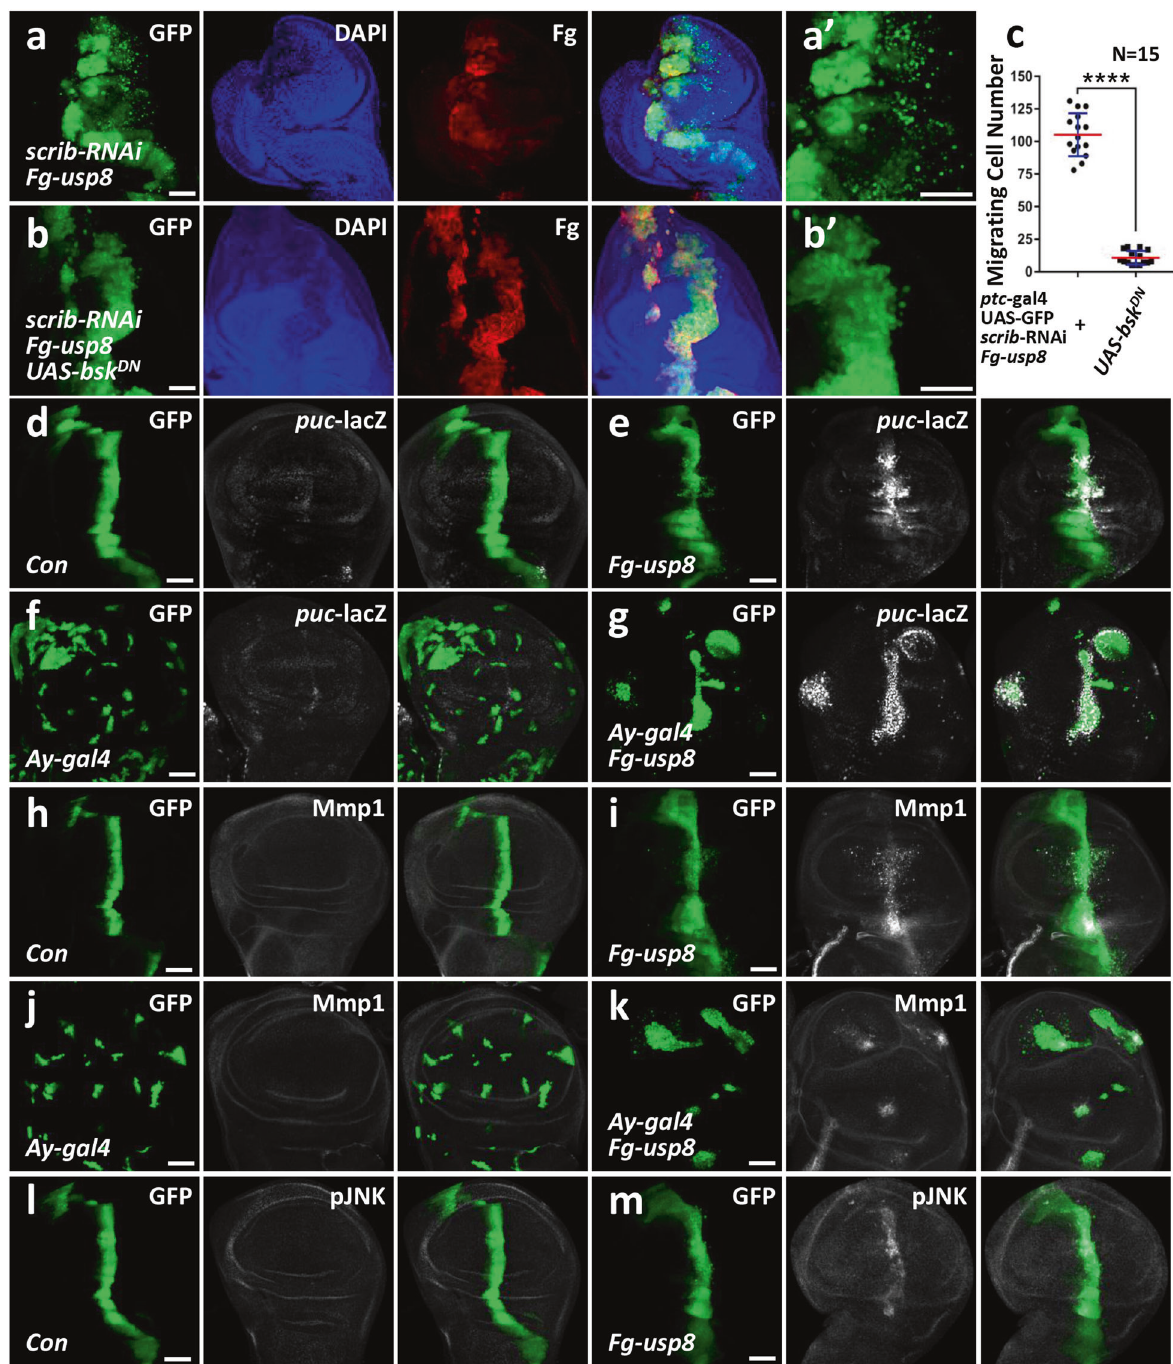
Fig. 2 Usp8 triggers cell migration through activating the JNK pathway. a Ectopic expression of usp8 under scrib RNAi background induced robust cell migration in the wing disc. a ’ was an enlarged fi gure of a . b Overexpression of bsk DN blocked usp8 -induced cell migration under scrib RNAi background. c Quanti fi cation analyses of migrating cell numbers in a, b ( N = 15). d A control third-instar larvae wing disc expressing GFP under ptc -gal4 driver was stained to show GFP (green) and puc -lacZ (white). e Overexpression of usp8 increased puc -lacZ level. f A control wing disc expressing GFP via FLP-out technique was stained with GFP (green) and puc -lacZ (white). g Ectopic expression of usp8 in the wing disc by FLP-out technique elevated puc -lacZ level. h A control wing disc expressing GFP under ptc -gal4 driver was stained to show GFP (green) and Mmp1 (white). i Overexpression of usp8 increased Mmp1 protein. j A control wing disc expressing GFP via FLP-out technique was stained with GFP (green) and Mmp1 (white). k Ectopic expression of usp8 in the wing disc by FLP-out technique elevated Mmp1 protein level. l A control wing disc expressing GFP was stained with GFP (green) and pJNK (white). m Overexpression of usp8 in the wing disc by ptc -gal4 elevated pJNK level. The t -test was used for statistical analyses, **** p < 0.0001. Scale bars: 50 μ m for all disc images.